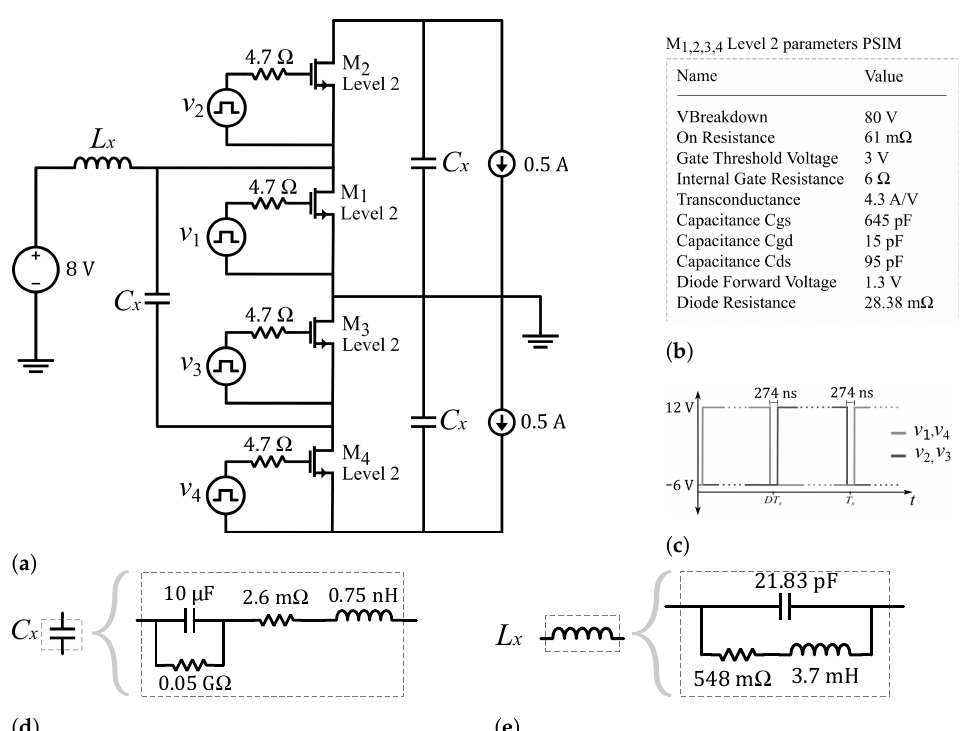
Figure 10. Simulation with real approximation of components. ( a ) Schematic; ( b ) Parame- ters mosfet IRF7380; ( c ) Gate control signal; ( d ) Capacitor approximation model; ( e ) Inductor approximation